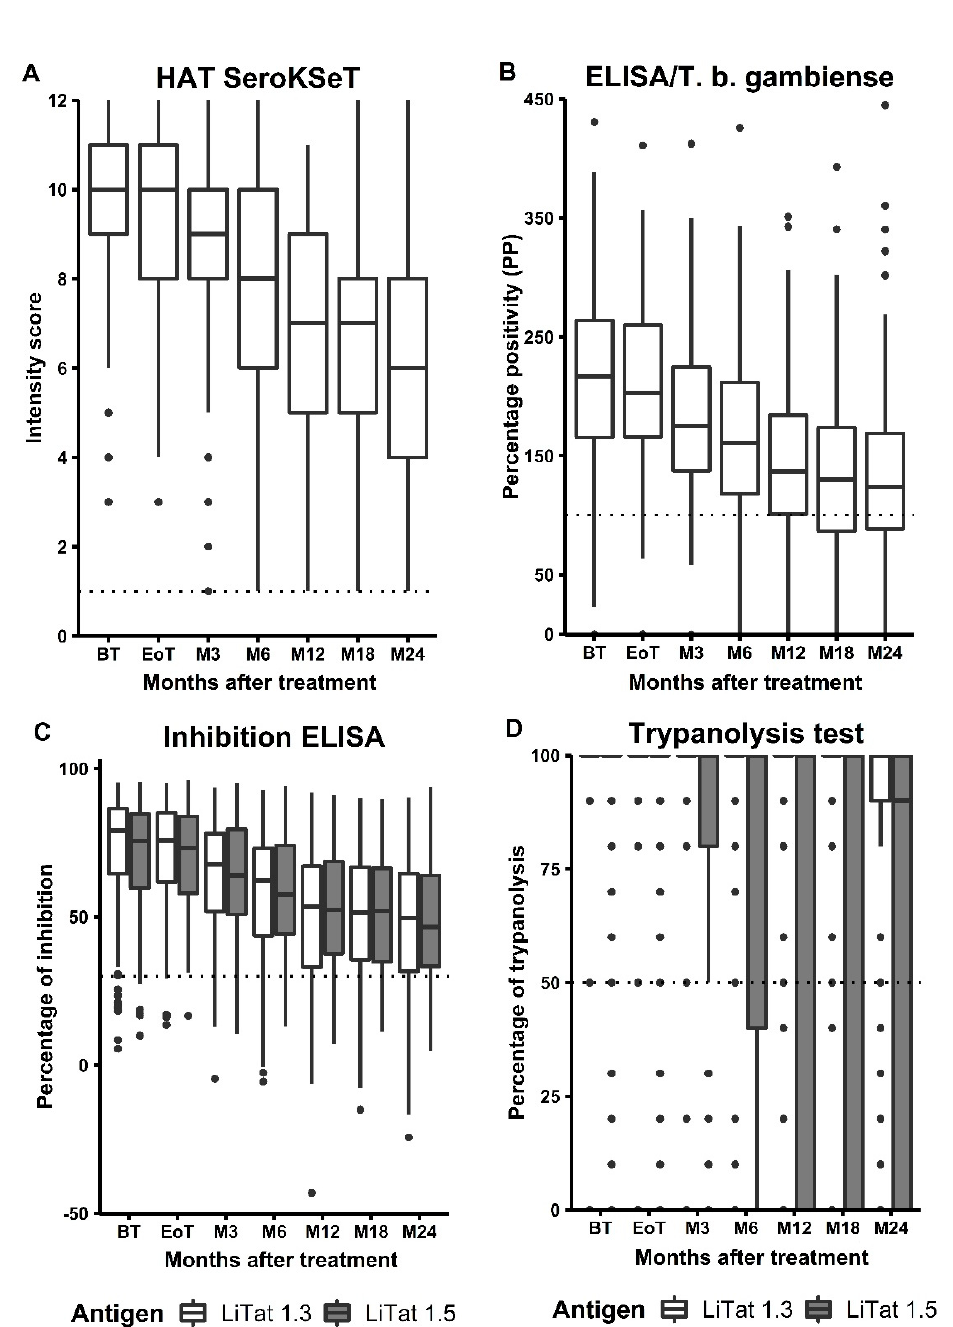
Figure 3. Evolution of intensity signal in the four serological tests over time. ( A ): Intensity signals of the RDT HAT Sero K -Set; ( B ): Intensity signals of the ELISA/ T.b. gambiense ; ( C ): Intensity signals of the iELISA and ( D ): Intensity signals of the immune trypanolysis test.